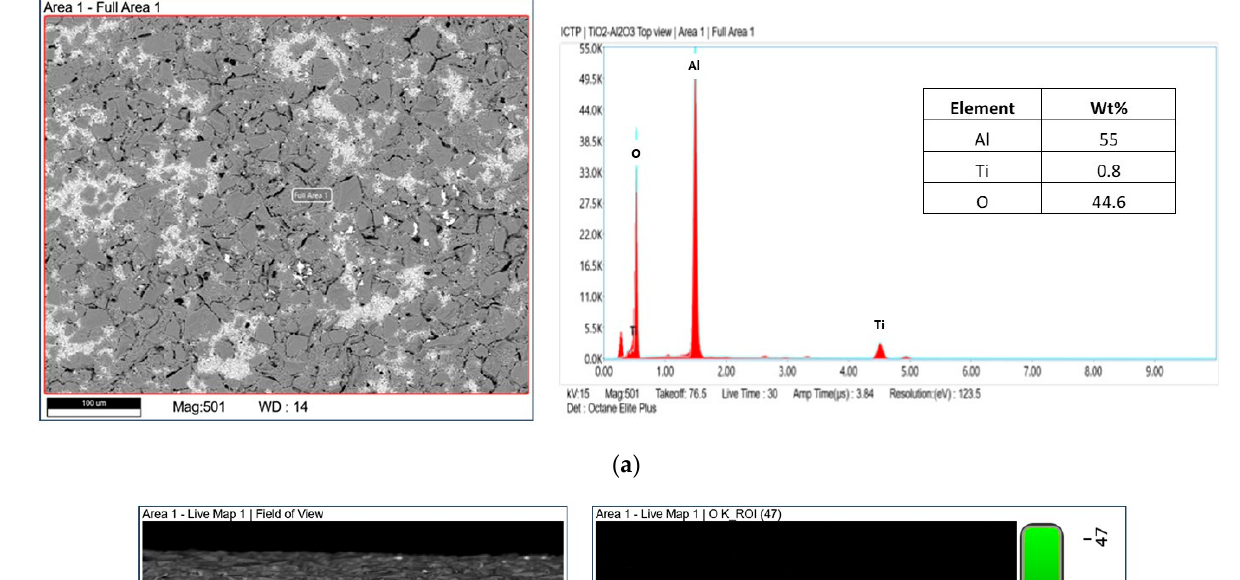
Table 4. Comparison with the water permeabilities of di ff erent inorganic photocatalytic mem- branes .